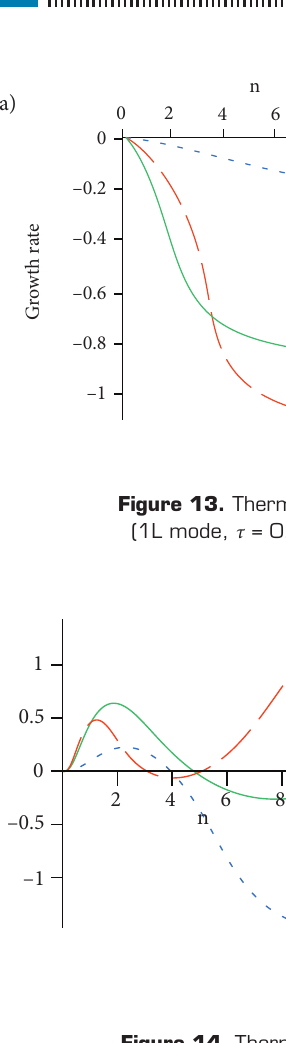
Figure 14. Thermoacoustic characteristics of a ducted resonator as flame position varies (3L mode, τ = 0.6, x = 0.5, V = 0.2, ω = 2) showing (a) growth rate and (b) frequency. h h